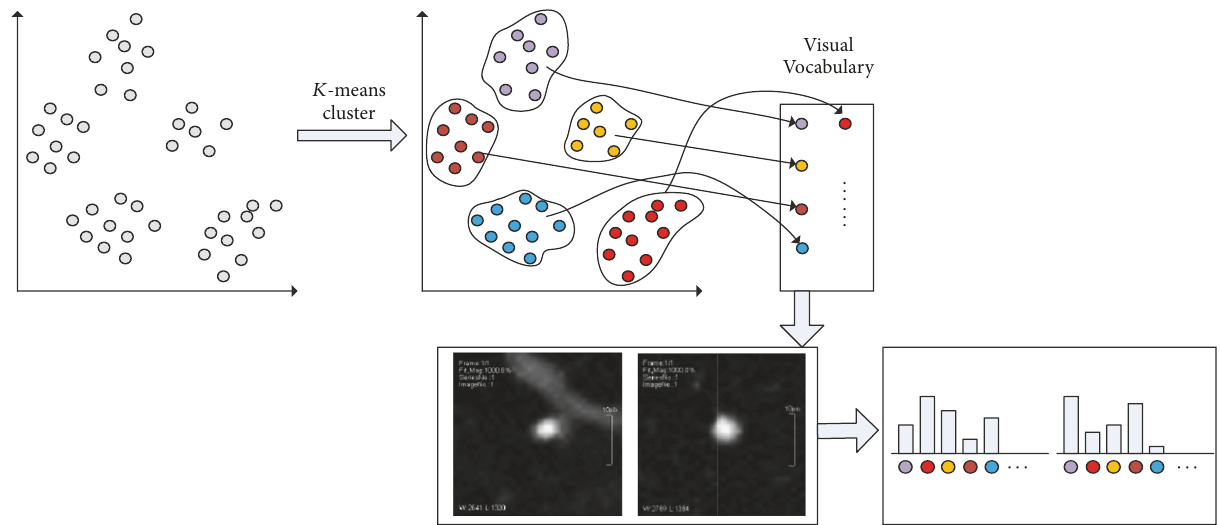
Figure 5: Procedure of BOVW representation of lung nodule